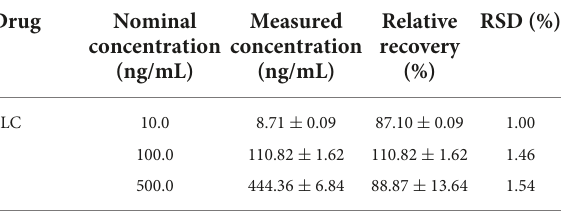
TABLE 4 Recovery of FLC in C. albicans lysate samples ( n =